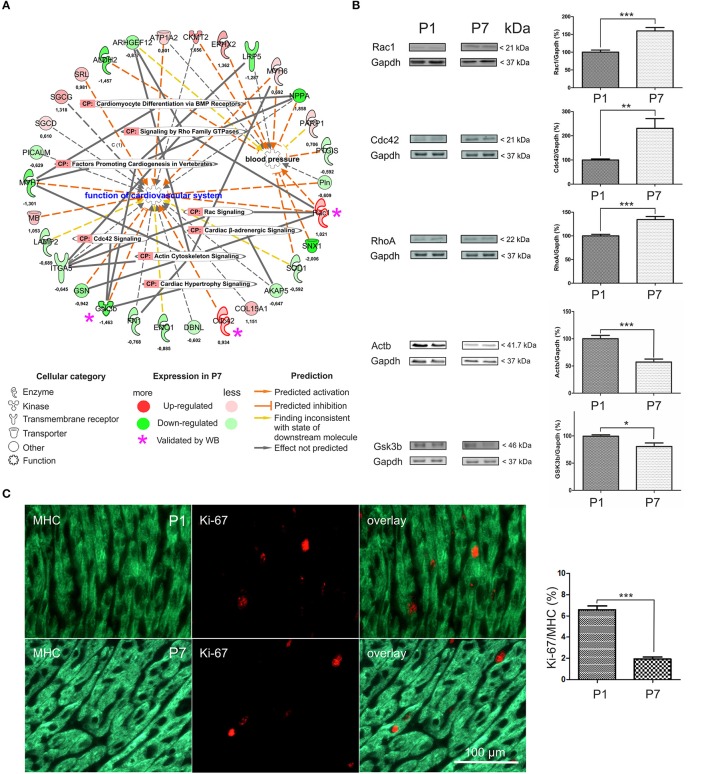
Functional annotation network analysis encompassing differentially expressed proteins in the mouse heart. (A) Eighteen down-regulated DEP and twelve up-regulated ones, including Rac1, Cdc42, and Gsk3b were functionally linked to Function of cardiovascular system, Rac and RhoA family GTPase and Cdc42 signaling, and Cardiac hypertrophy signaling. CP-canonical pathways. Log2FC-values of expression change are indicated, (B) Western Blot validation of differential expression data. P1- 1 day, P7- 7 days. *p < 0.05, **p < 0.01, ***p < 0.001 (heteroscedastic 2-tailed t-test), n = 6, (C) Representative Ki-67 and MHC stained samples of P1 and P7 myocardial tissues indicative of the amount of proliferative cardiomyocytes. n = 10 (P1) and n = 7 (P7), respectively. Mann-Whitney U-test, ***p < 0.001. 3262 (P1) and 2,747 (P7) cells / per group were counted.